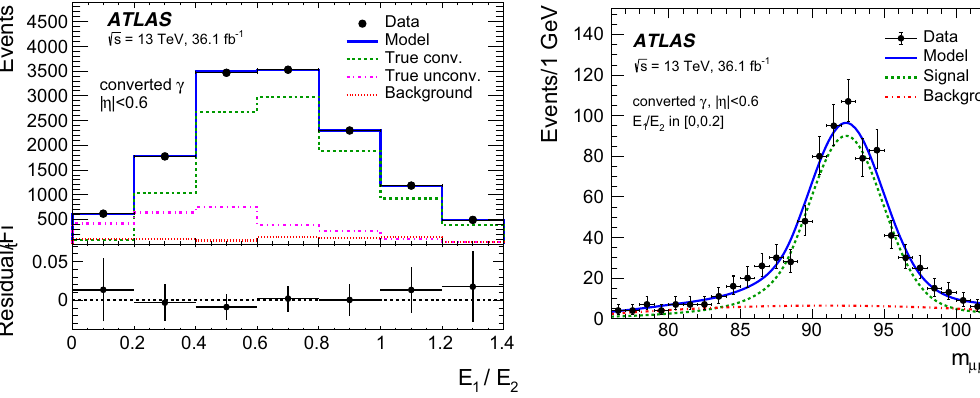
Fig. 18 Left: Distribution of E 1 / E 2 for converted photons with | η | < 0 . 6 in data (black points), for true converted photons (dashed green line), unconverted photons (dashed pink line), and background (dashed red line). The full model after the fit to data is also shown (solid blue